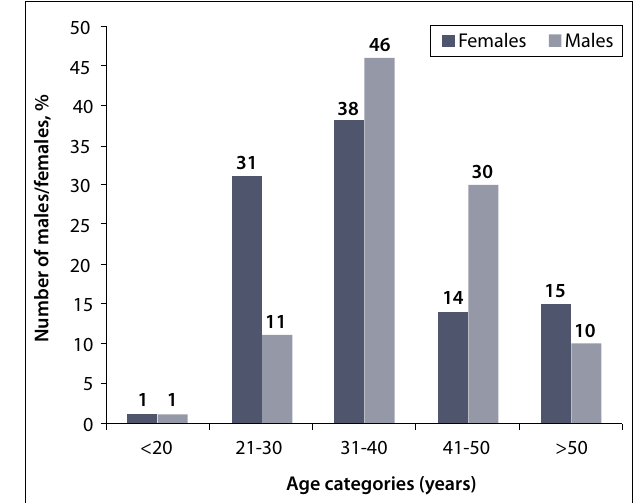
Fig. 1. HIV status of patients over the study period, indicating a positive trend for HIV infection.